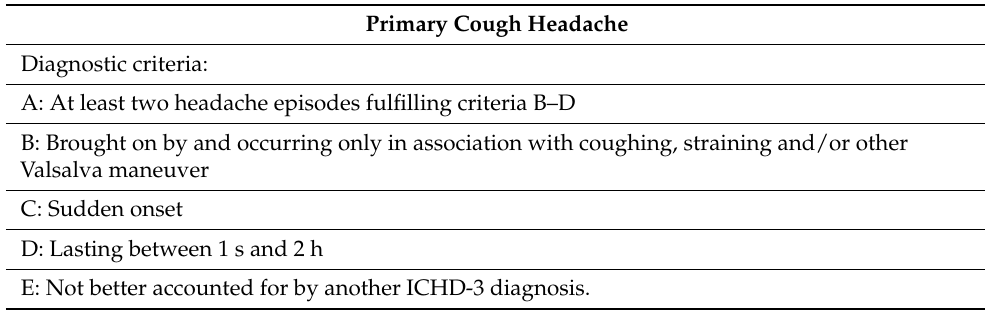
Table 1. ICHD-3 diagnostic criteria for Primary cough